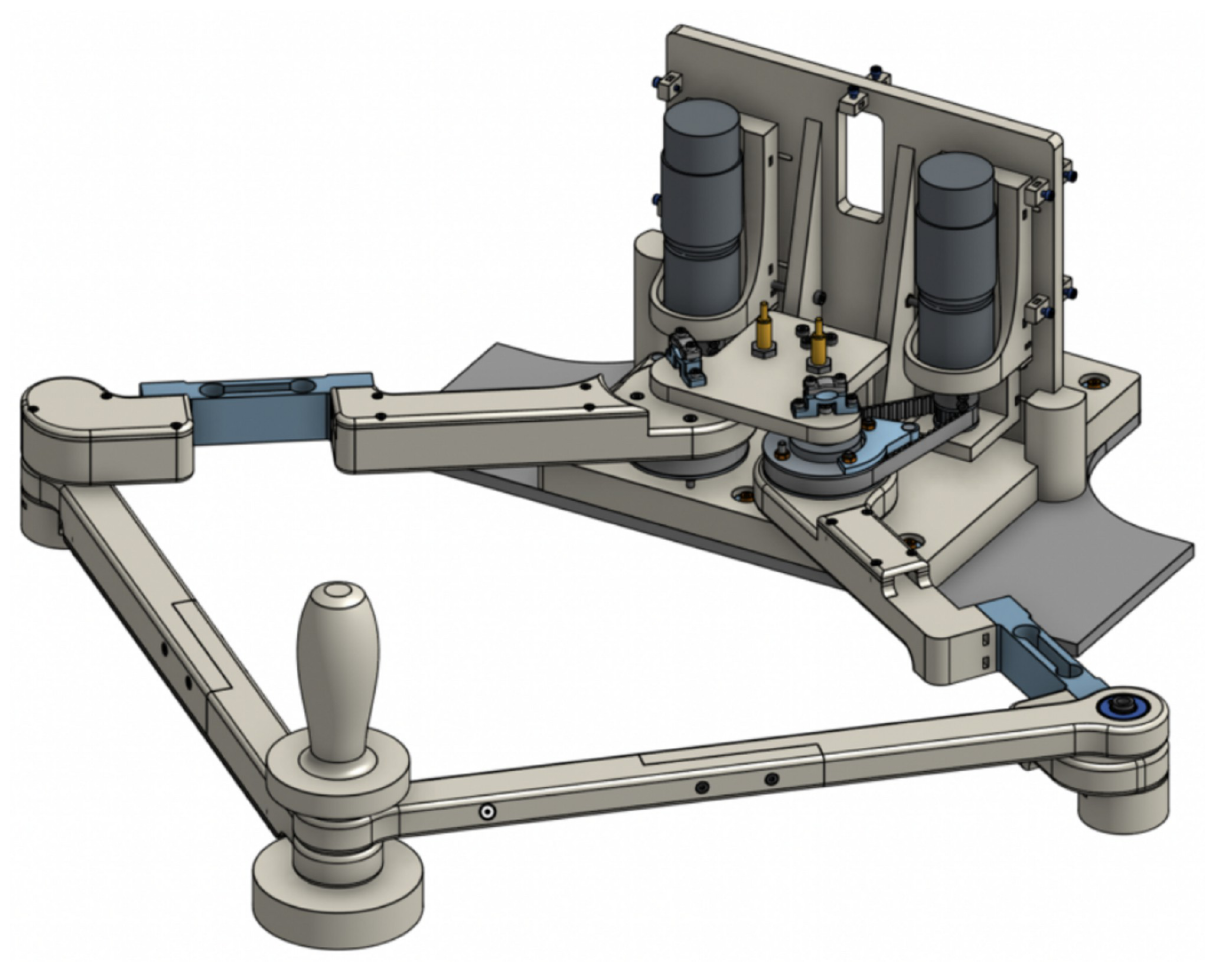
Fig 2. The PlanArm2